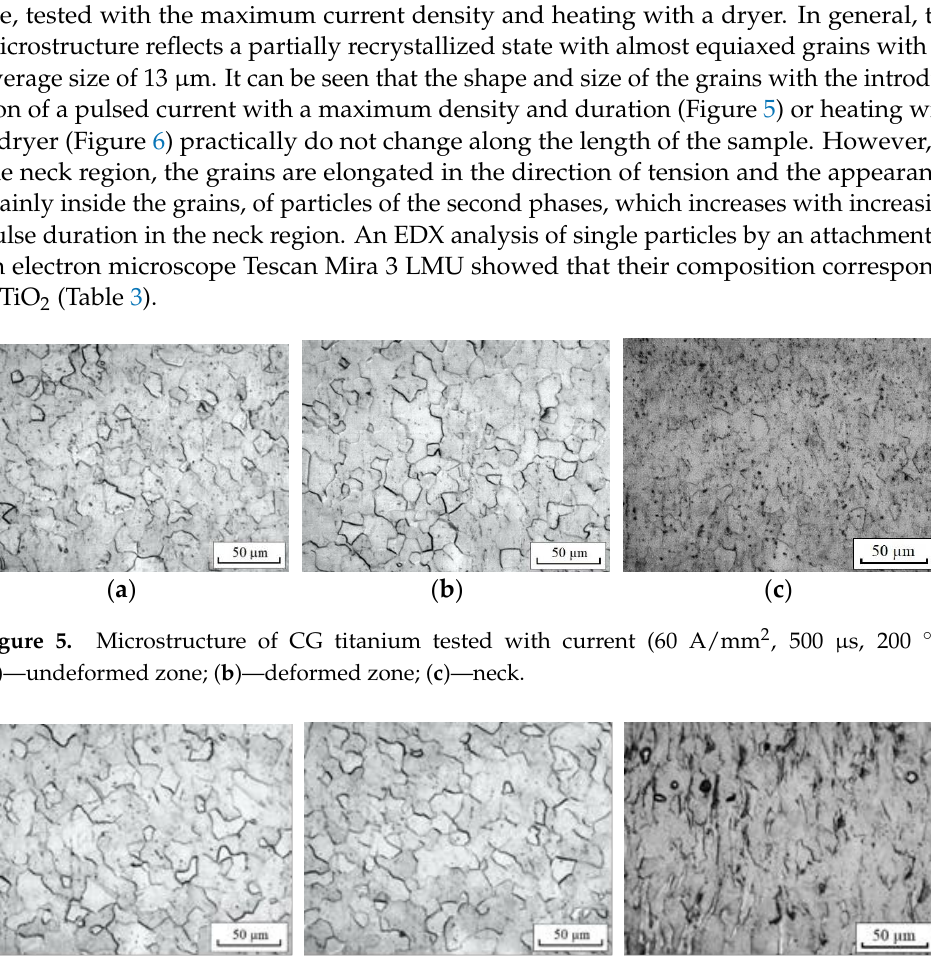
Table 3. The element content in the particles (wt.%).